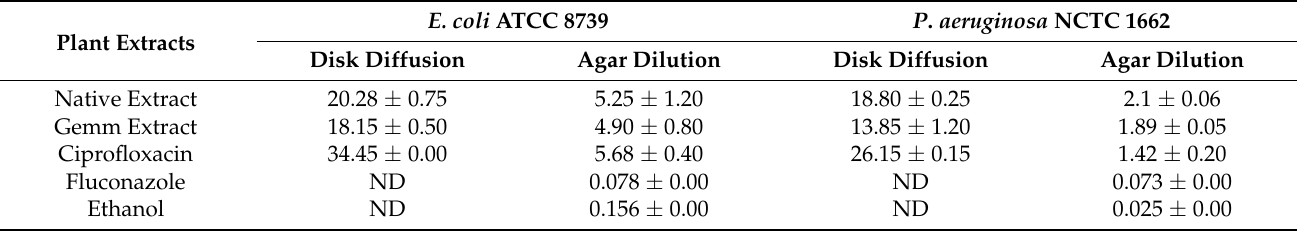
Table 3. Antimicrobial activity of native and gemm extracts of H . griffithi expressed as MIC ( µ g/mL) determined by disk diffusion and agar dilution methods against Gram-negative bacterial strains. Plant Extracts